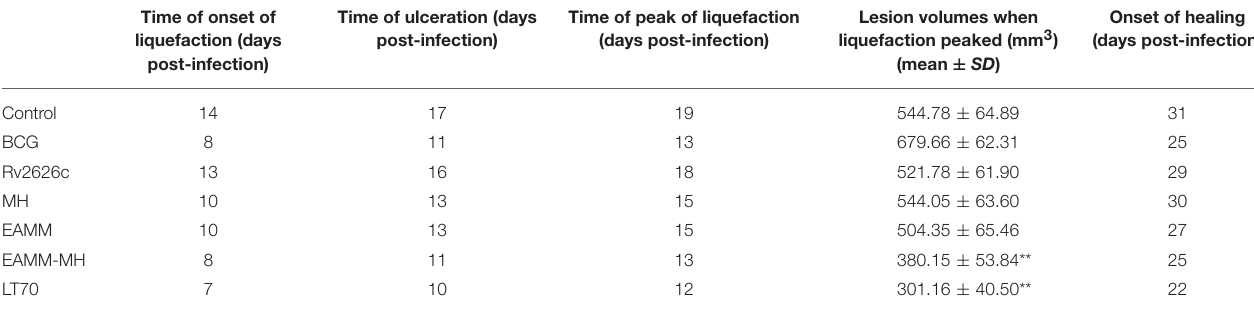
Lesion volumes when Onset of healing liquefaction peaked (mm 3 ) (days post-infection) (mean ± SD )